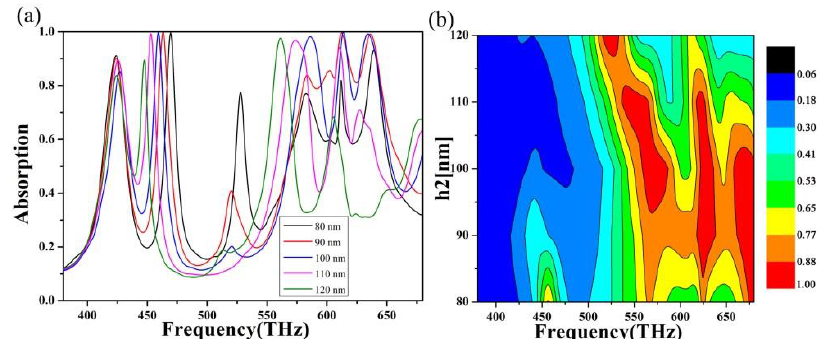
Figure 4. ( a ) Absorption curve and ( b ) absorption images of scanning dielectric layer thickness (80–120 nm) at 380–680 THz.